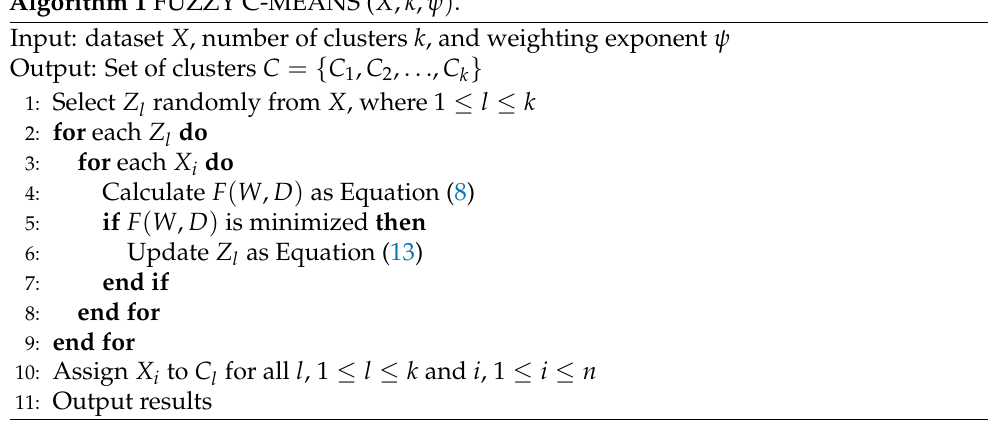
Algorithm 1 FUZZY C-MEANS ( X , k , ψ )